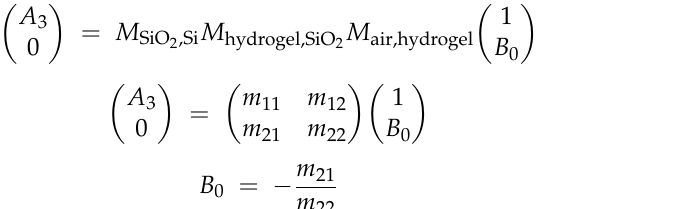
Figure 3. Schematic of the hydrogel layer on the silicon wafer. Arrows indicating the light beam. The A and B are the expansion coefficient of the electromagnetic wave propagating in the forward and backward direction in each layer.